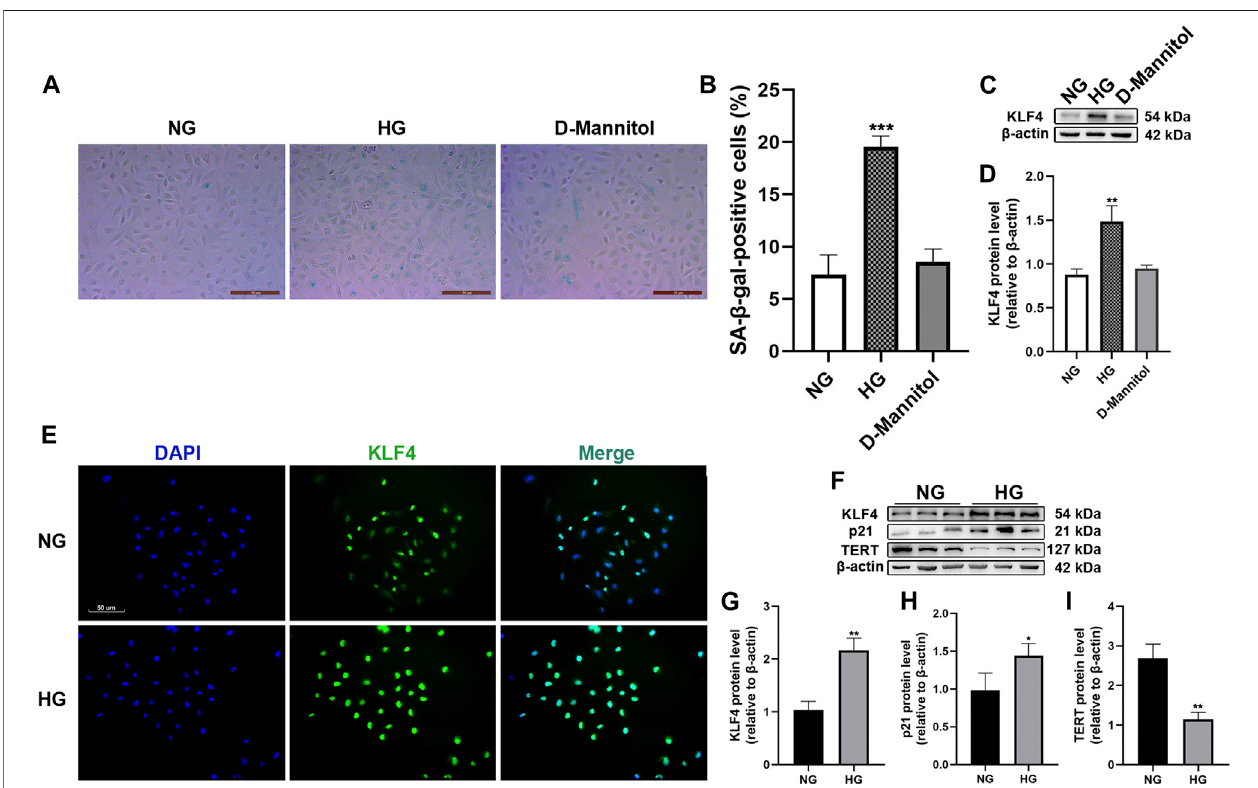
FIGURE1| EffectofHGexposureonKLF4,p21,andTERTexpressioninHUVECs. (A) Forthestudiescomparingtheeffectsofmannitol,HUVECswereincubated withmediaconsistingofNGorHG,andD-mannitolfor48 h.Cellswere fi xedandstainedforSA- β -galactivity.Theimagesaretakenby × 10magni fi cation. (B) Histogram represents the percentage of SA- β -gal-positive cells per microscopic fi eld. (C) Cell lysates were used to determine the KLF4 protein levels. (D) Results were normalized tocontrols,andhistogramsrepresenttherelativeintensityofKLF4.Valuesrepresentmean ± SEM( n (cid:2) 3 – 4pergroup).** p < 0.01,*** p < 0.001,signi fi cantlydifferent from NG. (E) HUVECs were also cultured either in NG or HG media for 48 h, and intracellular KLF4 levels were measured by immuno fl uorescence staining. The images weretakenat × 100magni fi cationandsectionswerestainedwithKLF4(green)andDAPI(blue).Arepresentativeimagefromthreeseparateexperimentsisillustrated. (F) KLF4, p21, and TERT protein levels were determined by immunoblotting . (G – I) Results were normalized to controls, and histograms represent the relative intensity of KLF4, p21, and TERT. Values represent mean ± SEM ( n (cid:2) 3 – 4 per group). **p < 0.01, *** p < 0.001, signi fi cantly different from